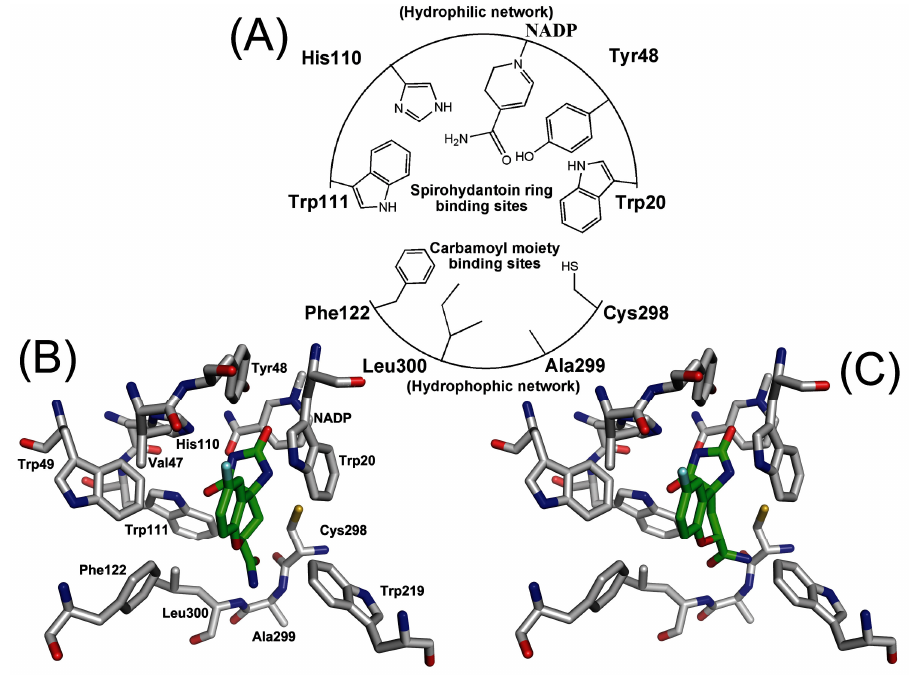
Figure 6. (A) Schematic diagram depicting the pharmacophores of ALR2 consisted of the active residues. Stereoview of (B) (2 S ,4 S )-Fidarestat and (C) (2 R ,4 S )-Fidarestat bounded into the active site of ALR2. This is average structure from molecular dynamics